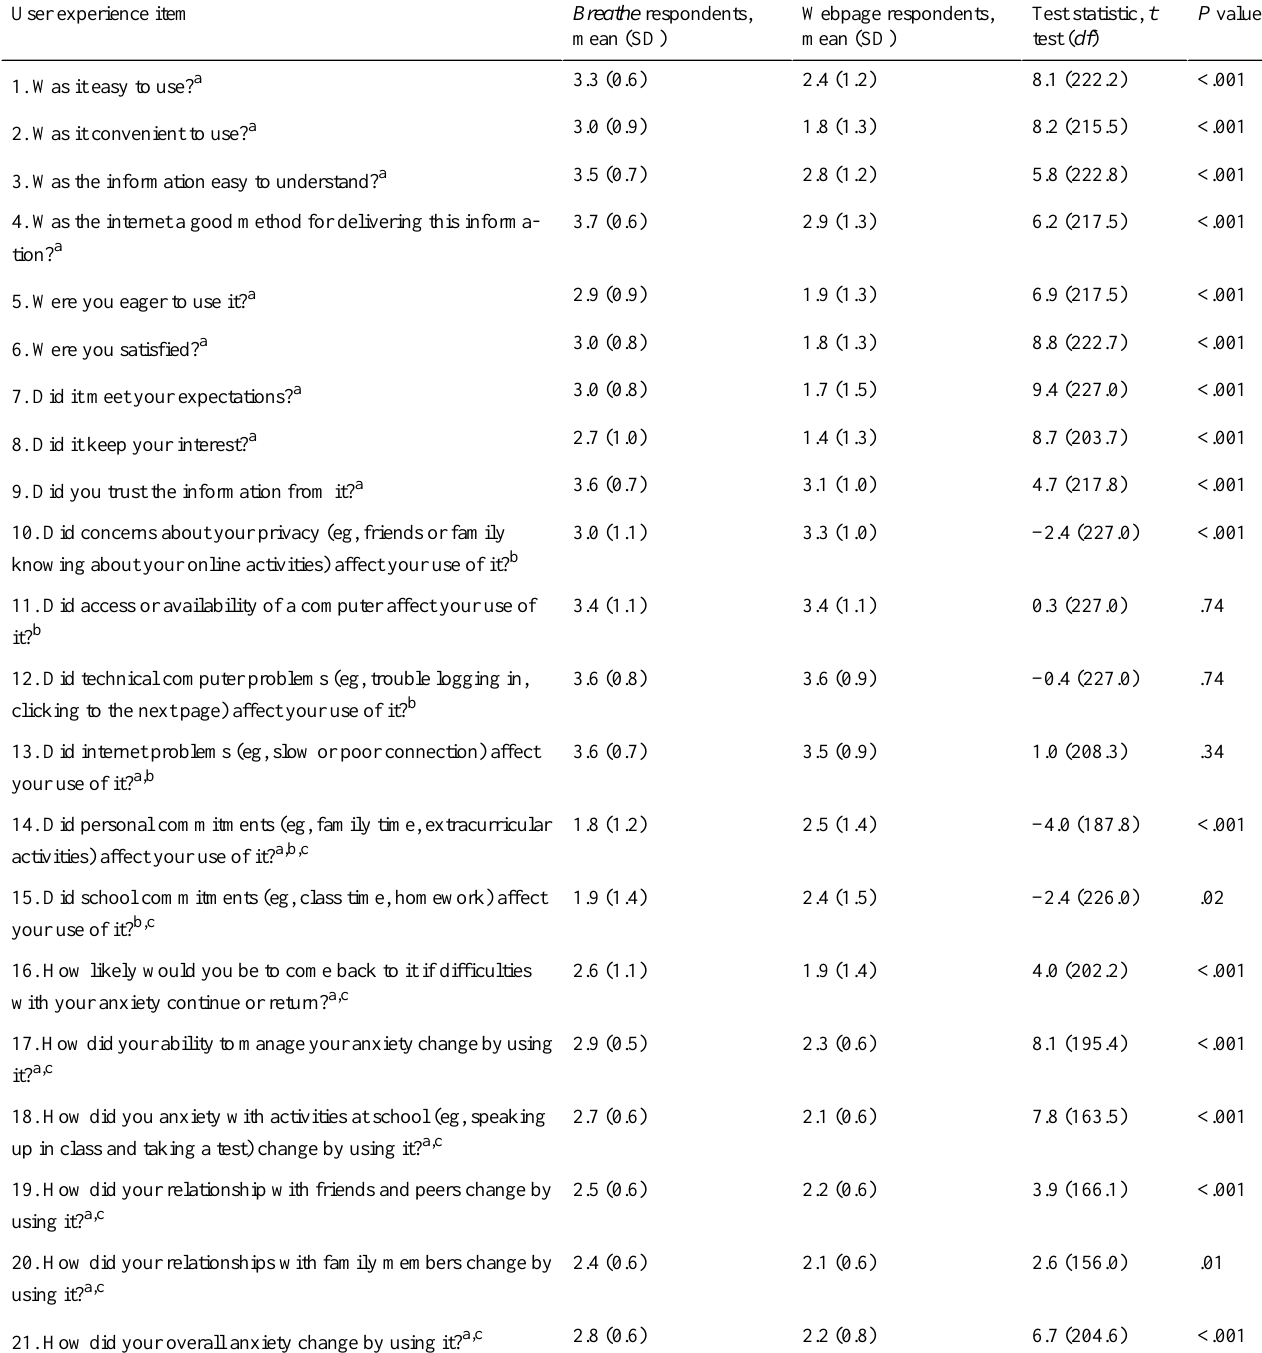
Table 6. The differences in core items of the User Experience Questionnaire for Internet-based Interventions between Breathe respondents (n=81) and webpage respondents